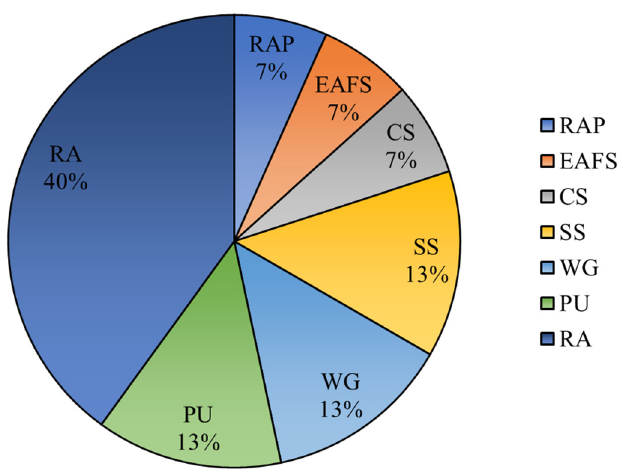
Figure 7. Distribution of materials used as a replacement for aggregates in the